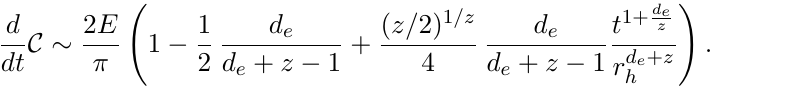
Figure 4 . Rate of the complexity growth in a WDW patch for Vaidya geometry with d and d e = 2